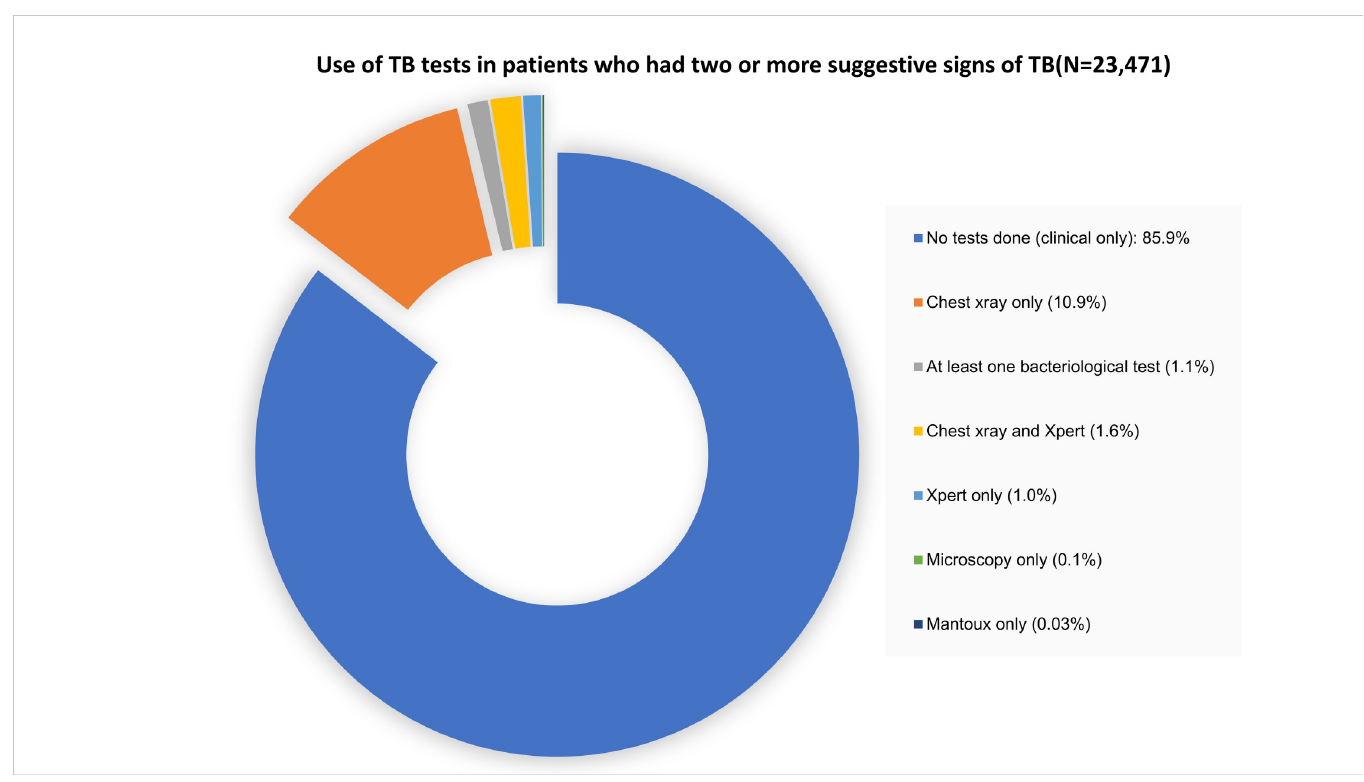
Fig 4. Use of TB tests in eligible